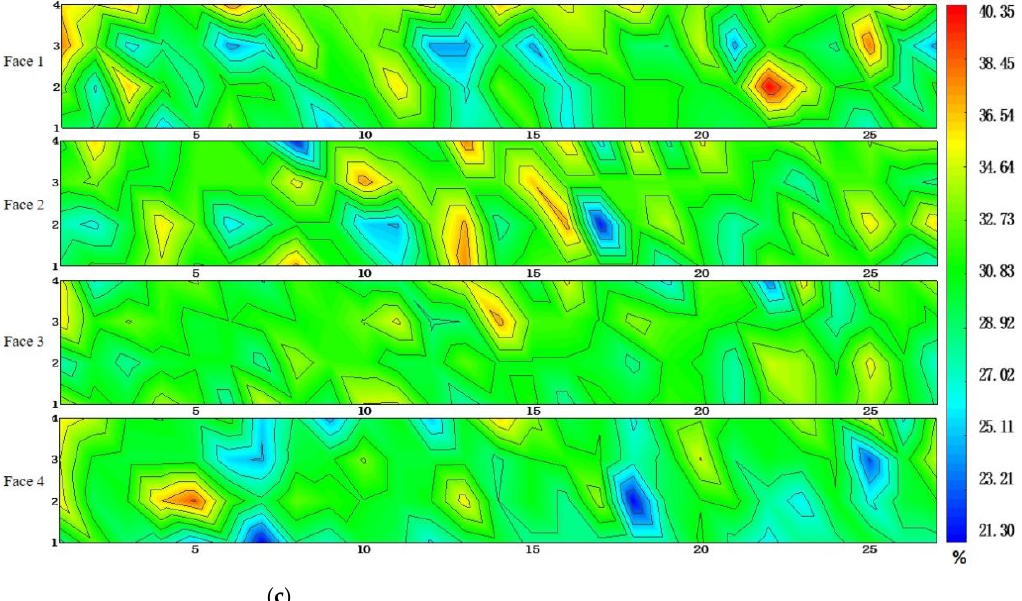
Figure 4. Contours of the area ratios of the ceramsite beads in the cut faces: ( a ) panel 1, ( b ) panel 2, ( c ) panel 3.